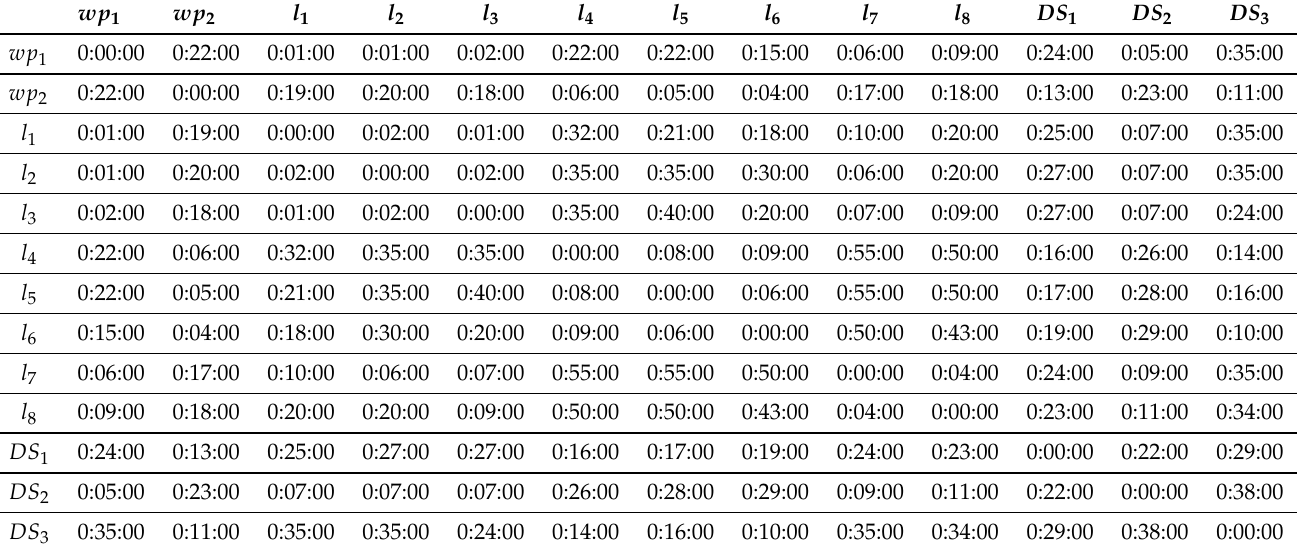
Table A3. Time distance matrix based on car displacements. A cell c ij indicates the time required to move from location i